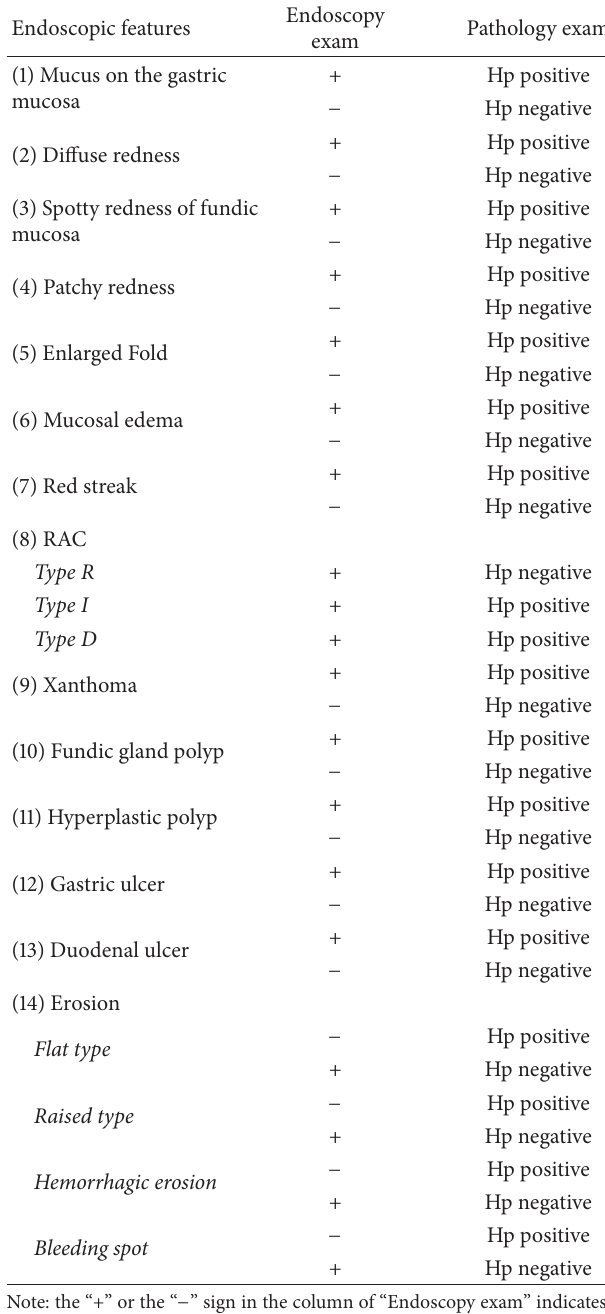
Table 1: Significant endoscopic features used for H. pylori diagnosis in relation to pathological